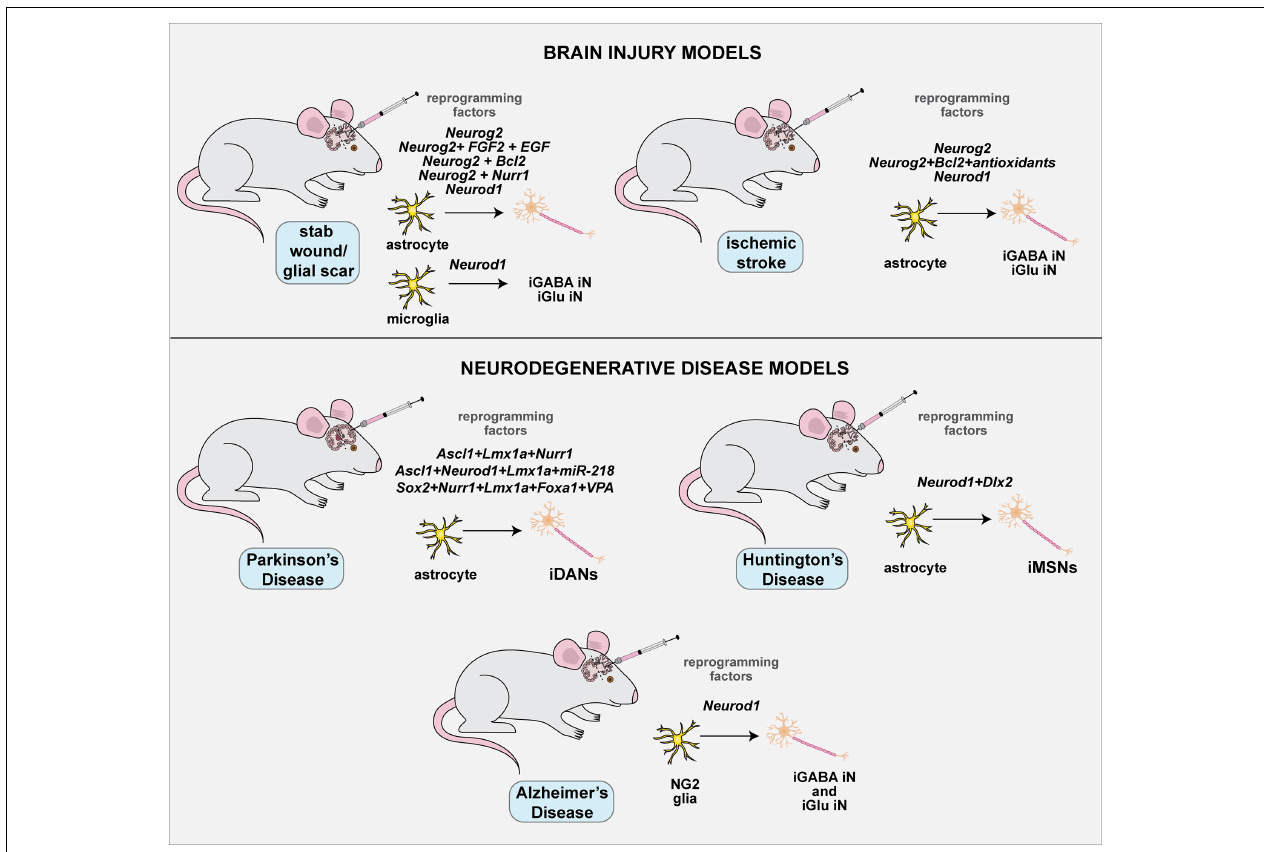
FIGURE 6 | Applications of in vivo direct neuronal reprogramming to treat injury and/or neurodegenerative disease. Direct neuronal reprogramming has therapeutic potential for brain injury (e.g., glial scars, stroke) and neurodegenerative diseases, such as PD, HD, and ALS. The advantage of this approach is that endogenous glial cells can be directly reprogrammed to replace lost neurons at the site of injury or